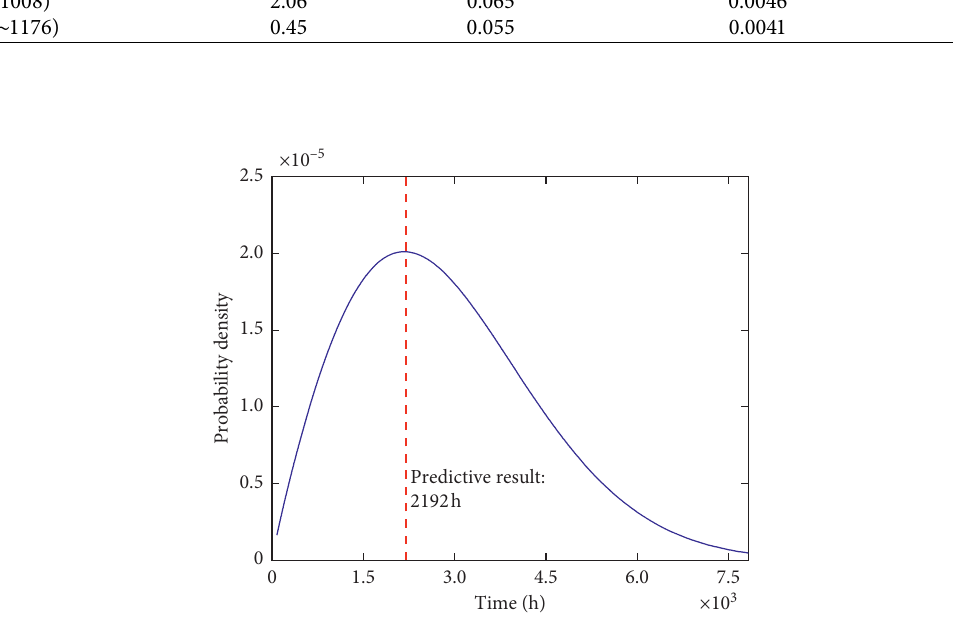
Figure 12: The distribution of RUL probability